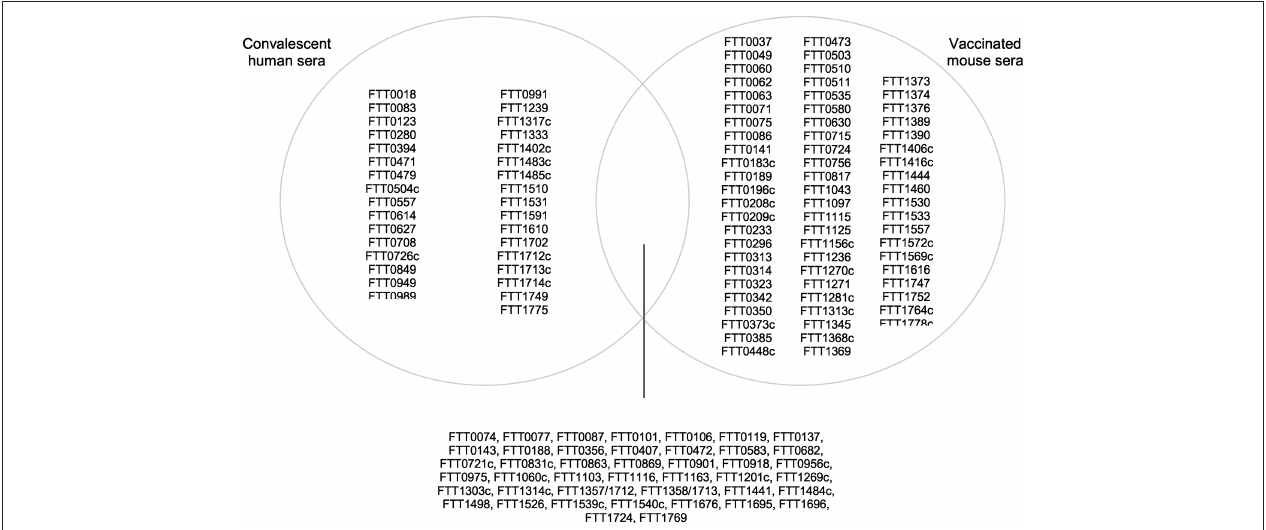
FIGuRE 5 | Venn diagram showing the intersection of immunoreactive proteins observed to be reactive with sera from LVS vaccinated mice and human convalescent. From Table 3.